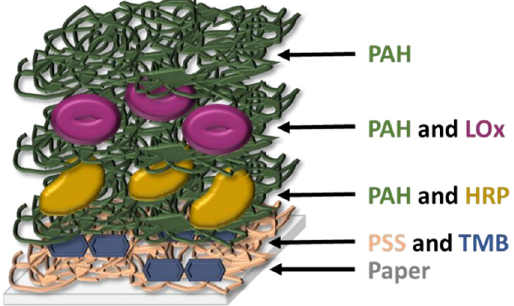
Figure 4. Schematic structure of the multi-layer sensor designed by Calabria et al. [113] (redrawn). PAH: poly(allylamine hydrochloride); PSS: poly(styrene sulfonate); LOx: L-lactate oxidase; HRP: horse radish peroxidase; TMB: 3,3 ′ ,5,5 ′ -tetramethylbenzidine.